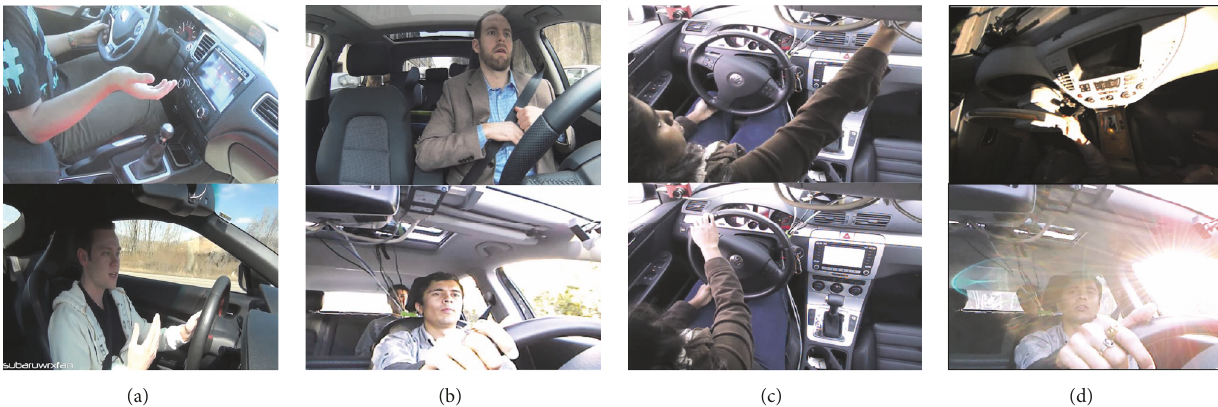
Figure 10: Examples of the VIVA hand detection dataset: (a) different view points; (b) skin-like nonhand objects appear in the image; (c) occlusion examples; (d) illumination variations.